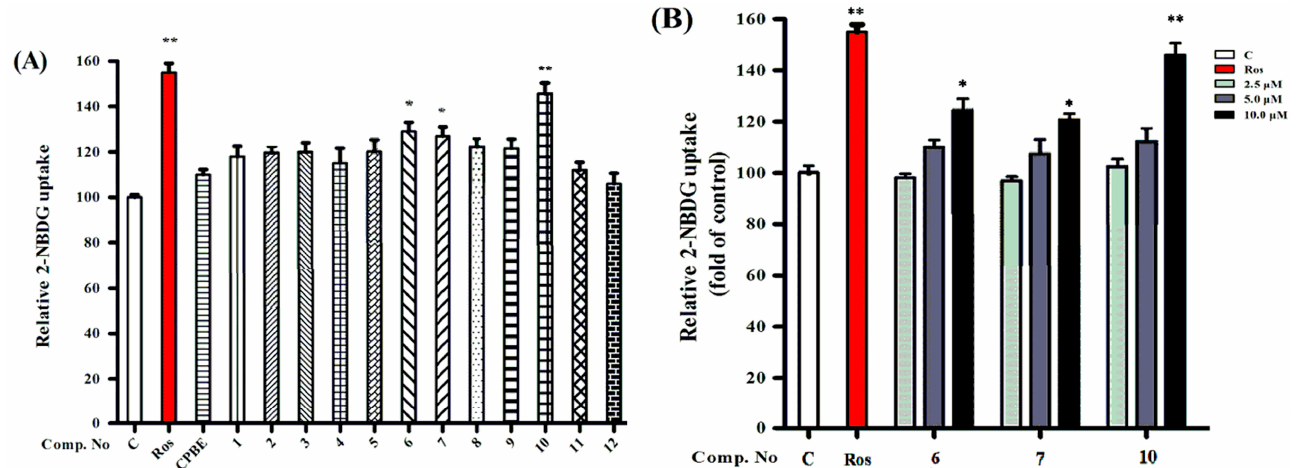
Figure 4. ( A ) The glucose uptake e ff ects of compounds 1 – 12 on 3T3-L1 adipocytes using a fl uores- cent derivate of cells at 10 µM. ( B ) Compounds 6 – 7 and 10 increased glucose uptake in 3T3-L1 ad- ipocytes. The di ff erentiated 3T3-L1 adipocytes were treated with compounds 6 – 7 and 10 at various concentrations (2.5, 5.0, and 10 µM) for 1 h. These results are expressed as the mean ± SD ( n = 3) of triplicate analysis; * p < 0.05 and ** p < 0.01.